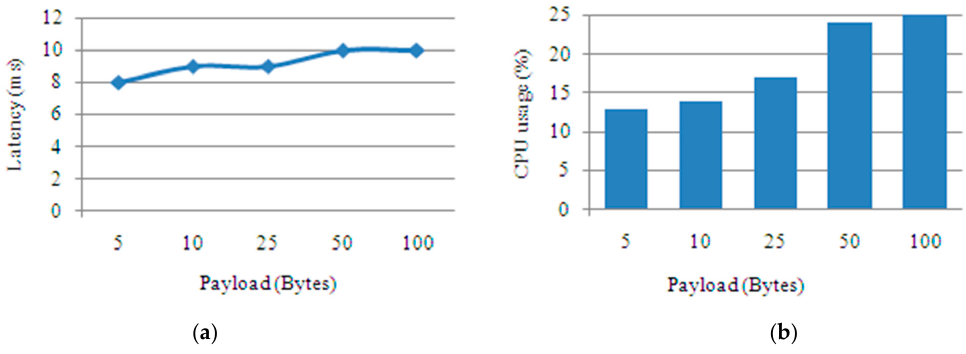
Figure 10. MQTT-related measurements: ( a ) Round-Trip Time (RTT); ( b ) CPU usage.